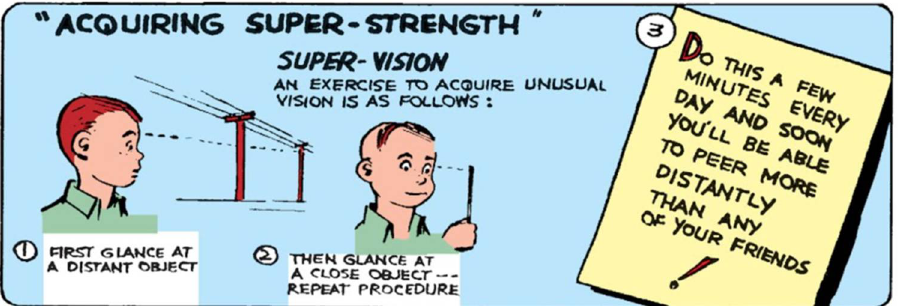
Figure 20. Joe Shuster, Closing Panel: “Acquiring Super-Strength,” 1938. Siegel and Shuster (January